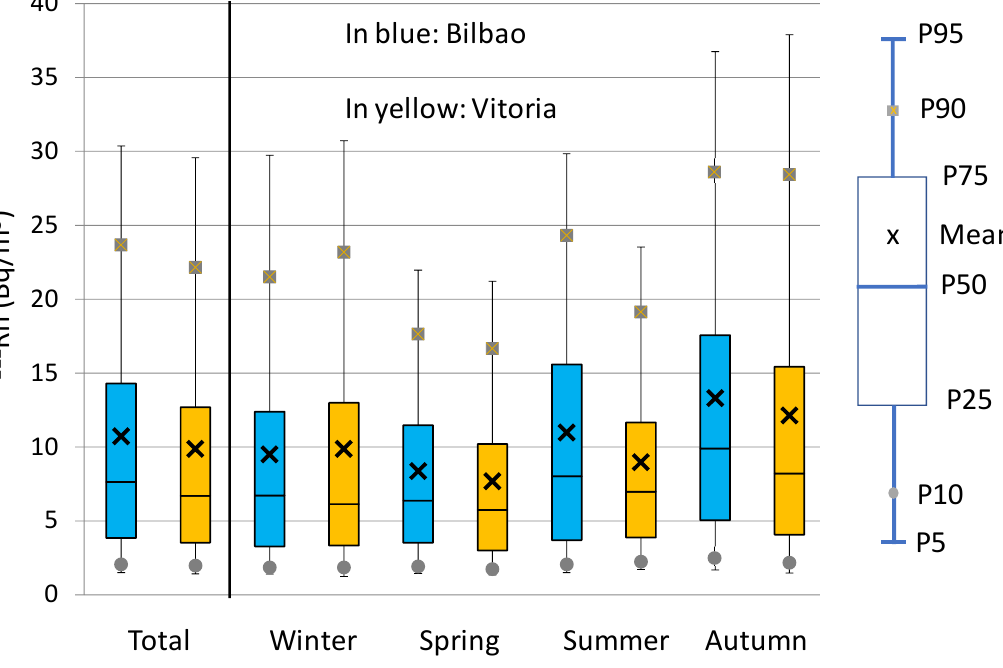
Figure 3. Box plots for hourly 222 Rn concentrations during the period June 2012 – June 2015. The distribution of 222 Rn concentrations during the whole sampling period was wider in Bilbao than in Vitoria (Figure 3, left), and the largest differences between the two were found for the highest concentrations, i.e., the comparison shows how the percentiles above the 50th percentile in Bilbao were higher than those from Vitoria. This behaviour was also observed in spring and summer (Figure 4, right), but not in winter. Conversely, in autumn, the range of 222 Rn concentrations was wider in Bilbao, but the highest 222 Rn concentrations were reached in Vitoria. These results highlight the different seasonal patterns observed between Bilbao and Vitoria. Meteorological seasons were defined as follows: winter, January to March; spring, April to June; summer, July to September; and autumn, October to December. While in Vitoria, the widest distributions and highest values were registered in winter and autumn, in Bilbao, these were achieved in summer and autumn, which can clearly be attributed to the different locations of the cities, as well as the differences in the meteorological conditions between the two areas of the Basque country. This seasonal evolution, for instance, is similar to that obtained in the southern area of the Iberian Peninsula [12, 29] in which autumn was the season with the highest overall concentrations. Figure 4 shows the corresponding total and seasonal daily average 222 Rn evolution for these two sites on the basis of the 660 “pair s of days” identified during the sampling period. Similar trends in diurnal variations, with differences in magnitude, were ob- served. As expected, and on average (black line), 222 Rn follows the usual daily evolution cycle [34]. At both sites, the highest values were observed during the night (between 7:00 and 8:00 UTC), coinciding with low atmospheric boundary layer (ABL) height and stable stratified conditions limiting the transport and movement of air masses, and with low wind speed, favouring the accumulation of 222 Rn. After sunrise, the ABL becomes unsta- ble, and therefore gains height, diluting 222 Rn in a larger volume of air and, therefore, causing a decrease in 222 Rn activity concentrations. The minimum occurs between 17:00 and 18:00 UTC.